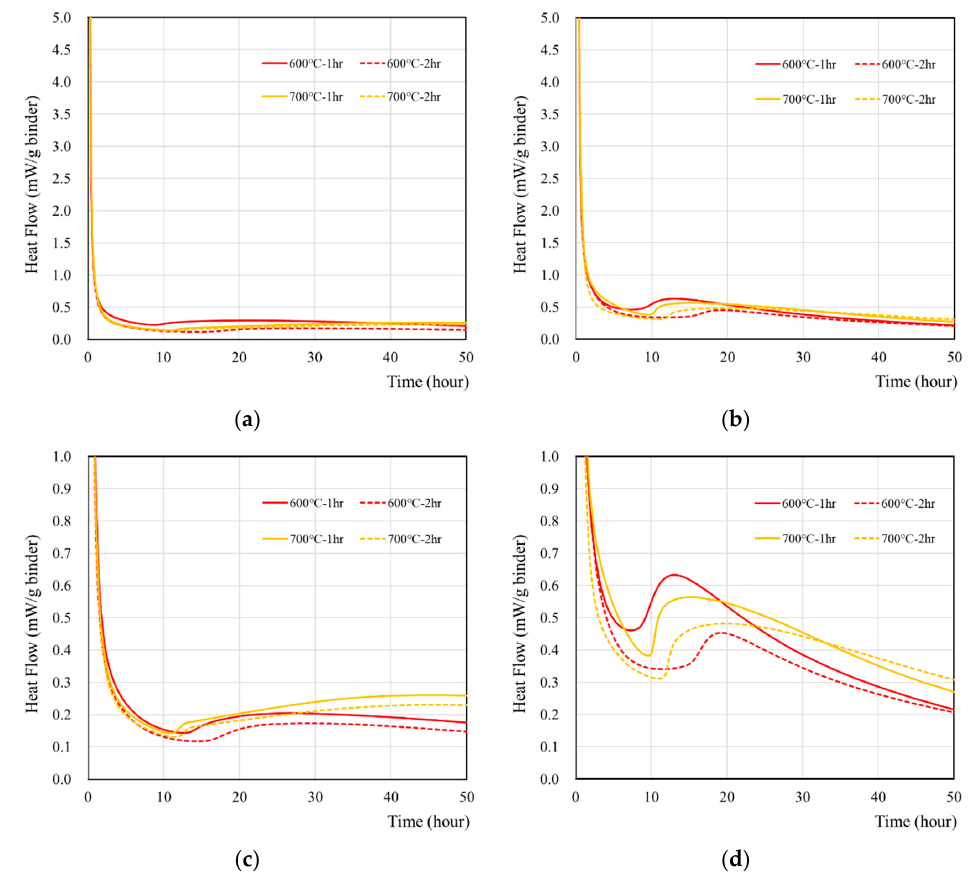
Figure 2. The heat flow of wasteform containing various types of liquids: ( a ) with deionized water, ( b ) with 1 M CsCl solution, ( c ) with deionized water, and ( d ) with a 1 M CsCl solution. Note that ( a , b ) were redrawn in the heat flow scale of 0–1.0 mW/g binder to facilitate the analyses.